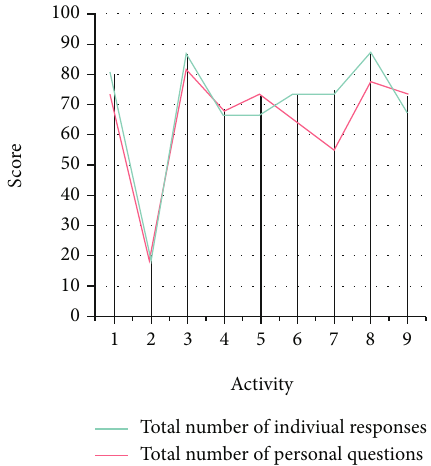
Figure 5: Visualization results of students ’ learning attitudes and necessary learning activities initiative.